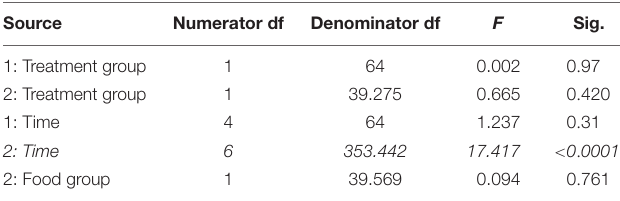
TABLE 7 | Fixed effects from the linear mixed effects model of total distance moved in study 1 (indicated by 1) and study 2 (2) between treatment groups, food groups, across time and their